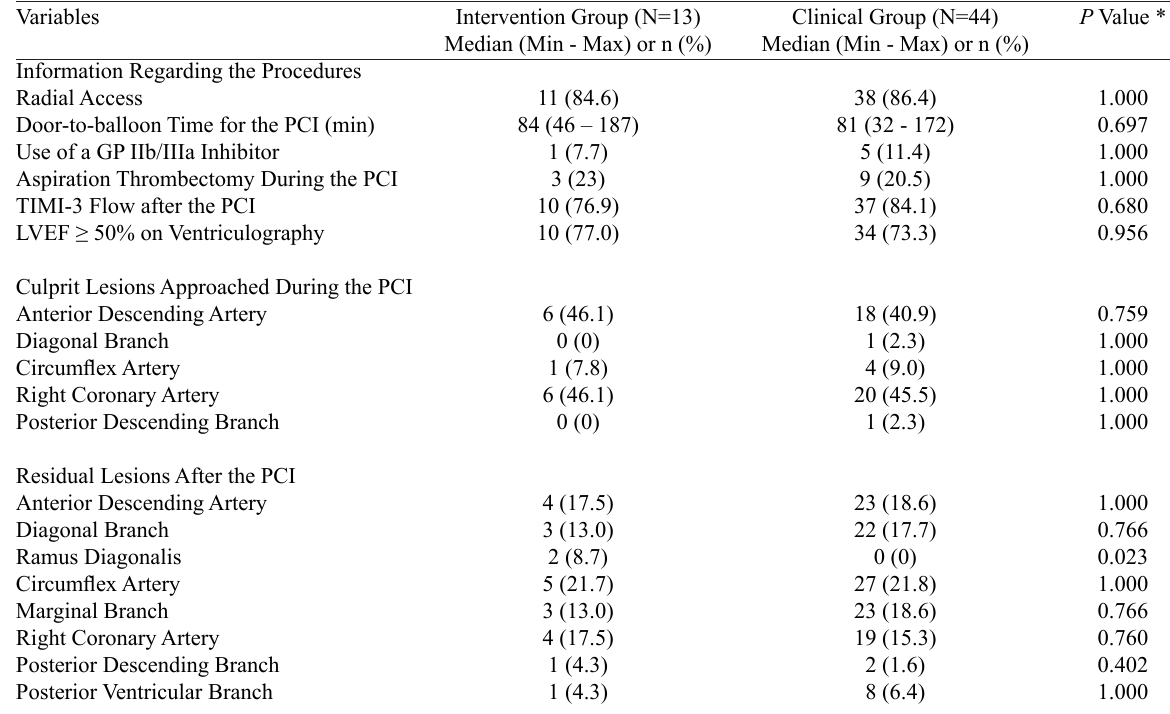
Table 2. Angiographic data from patients admitted with STEMI and undergoing primary PCI with bare metal stent implantation. Variables Information Regarding the Procedures Radial Access